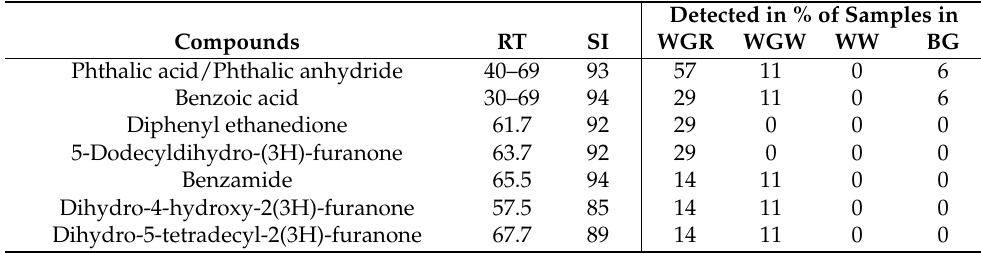
Table 2. Volatile organic compounds detected only in the exhaled breath samples after WG diets.